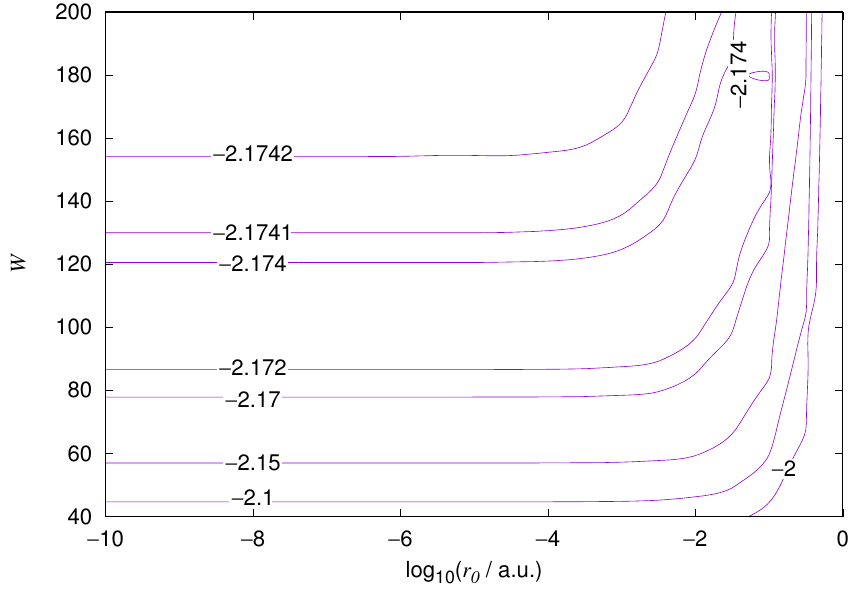
Figure 9. Helium 1s2s 1 S total energy. The HF limit is given in Table 1. Notations as in Figure 1.